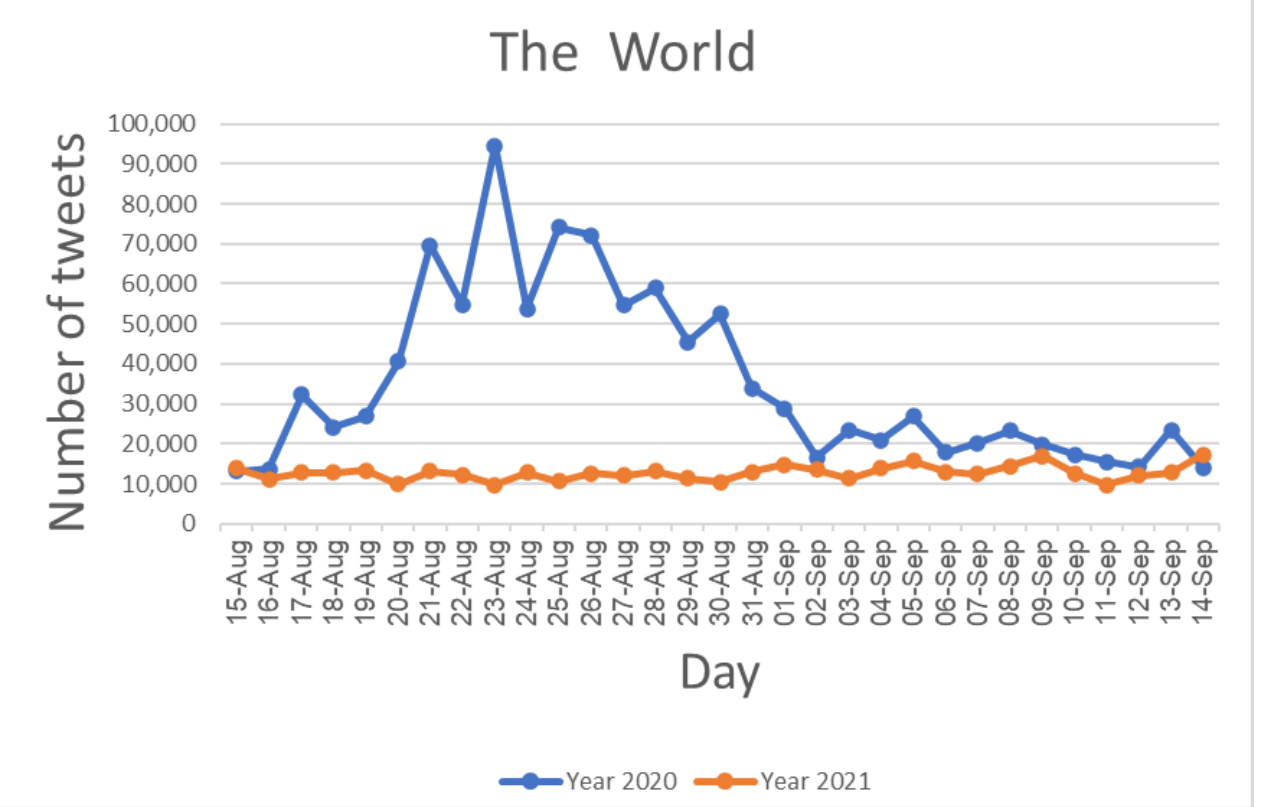
Figure 7. Frequency of tweets related to learning and assessment parameters.